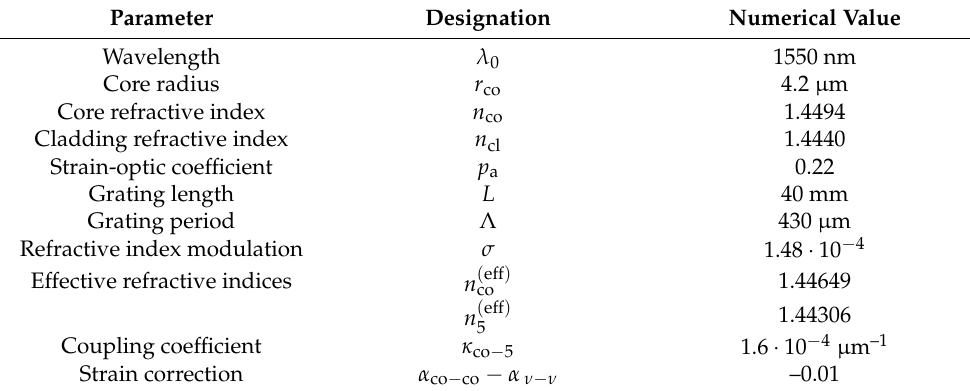
Table 1. Parameters used in simulation.